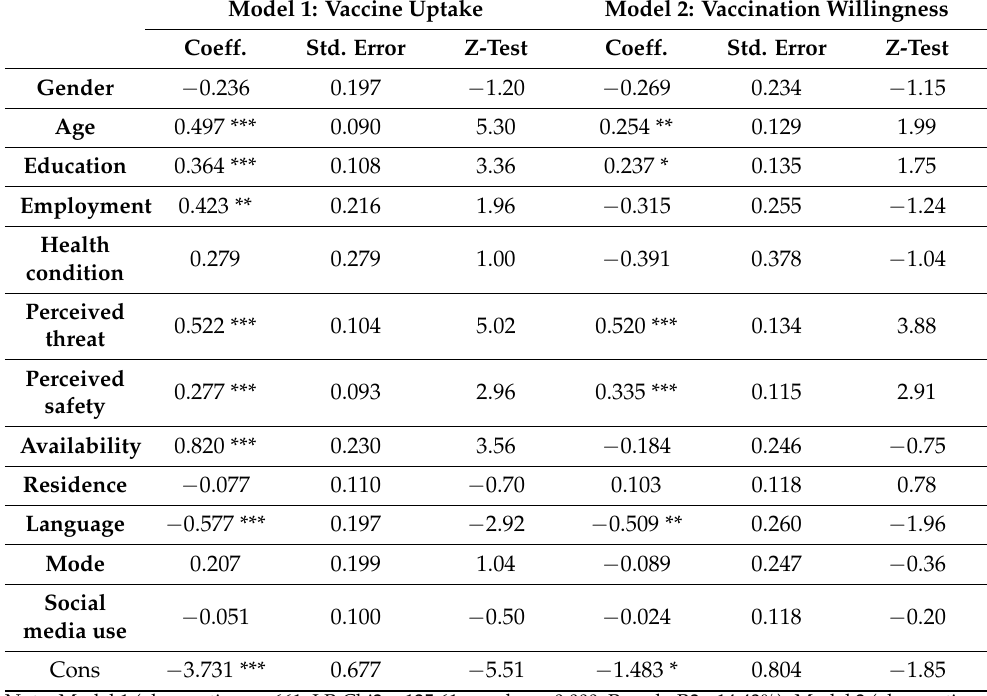
Table 3. Logistic regression analysis. Model 1: Vaccine Uptake Model 2: Vaccination Willingness Coeff. Std.